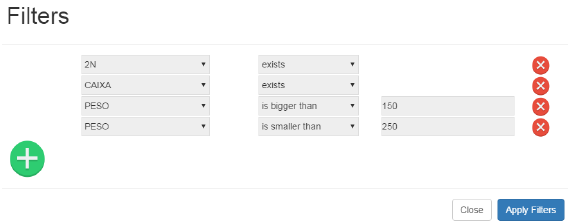
Figure 7. Filtering pop-up with four filters specified. The first and second lines indicate that all entries should have some value recorded for characteristics ’2N’ and ’CAIXA’ (i.e., filter out those specimens with null or zero values for these attributes). The third and fourth lines limit the value of the attribute ’PESO’ between 150 and